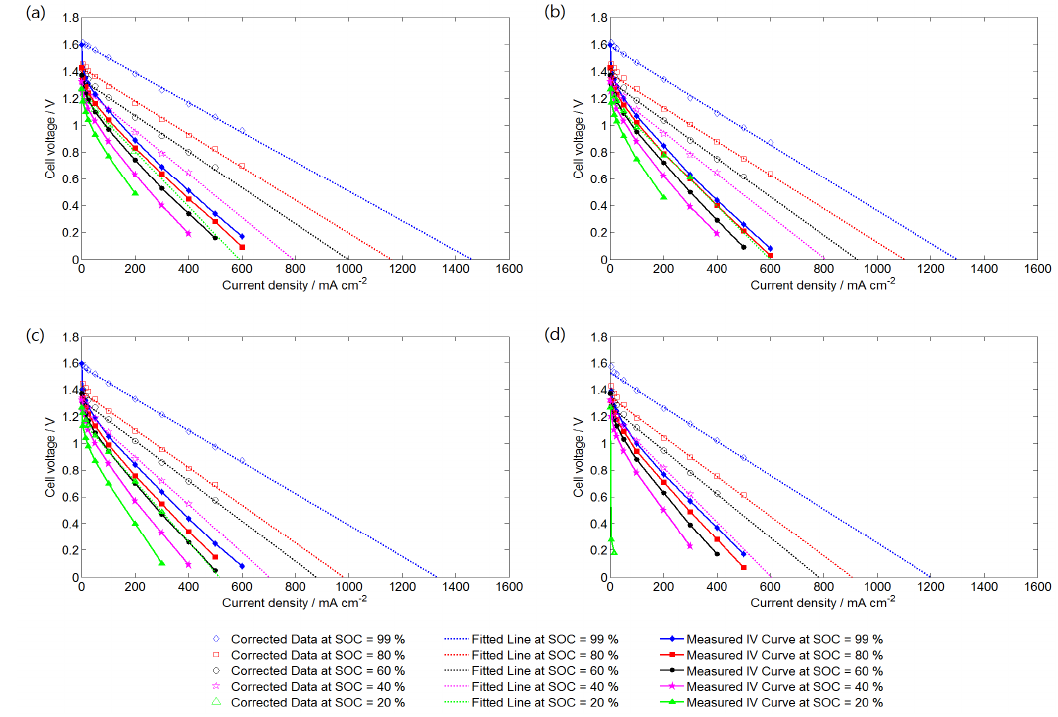
Figure 3. Measured polarization curves and corrected curves of the VRFB cell operating at different SR s: ( a ) SR = 20; ( b ) SR = 15; ( c ) SR = 10; and ( d ) SR =